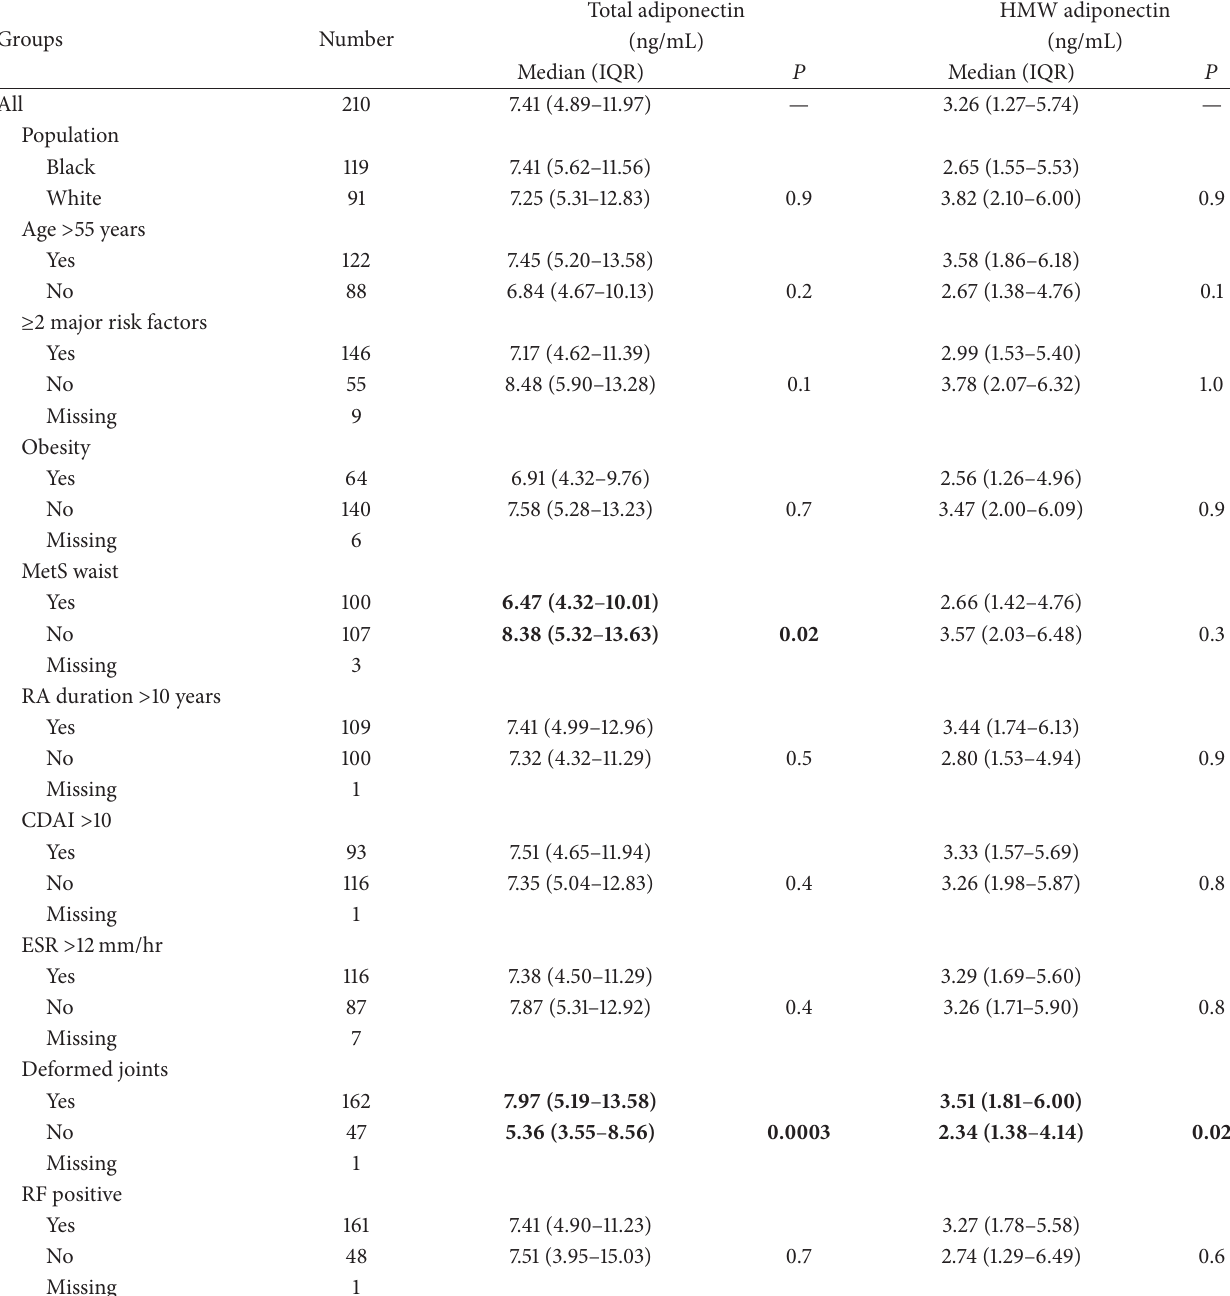
Table 1: Total and high molecular weight adiponectin in all 210 RA patients and